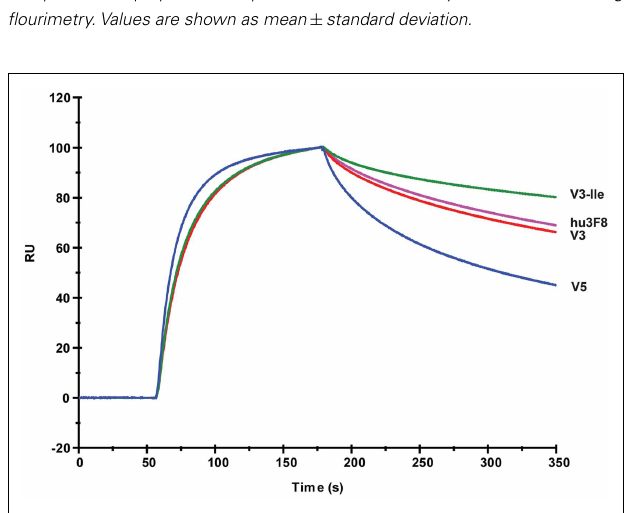
IN VITRO ANTIBODY-DEPENDENT CELL-MEDIATED